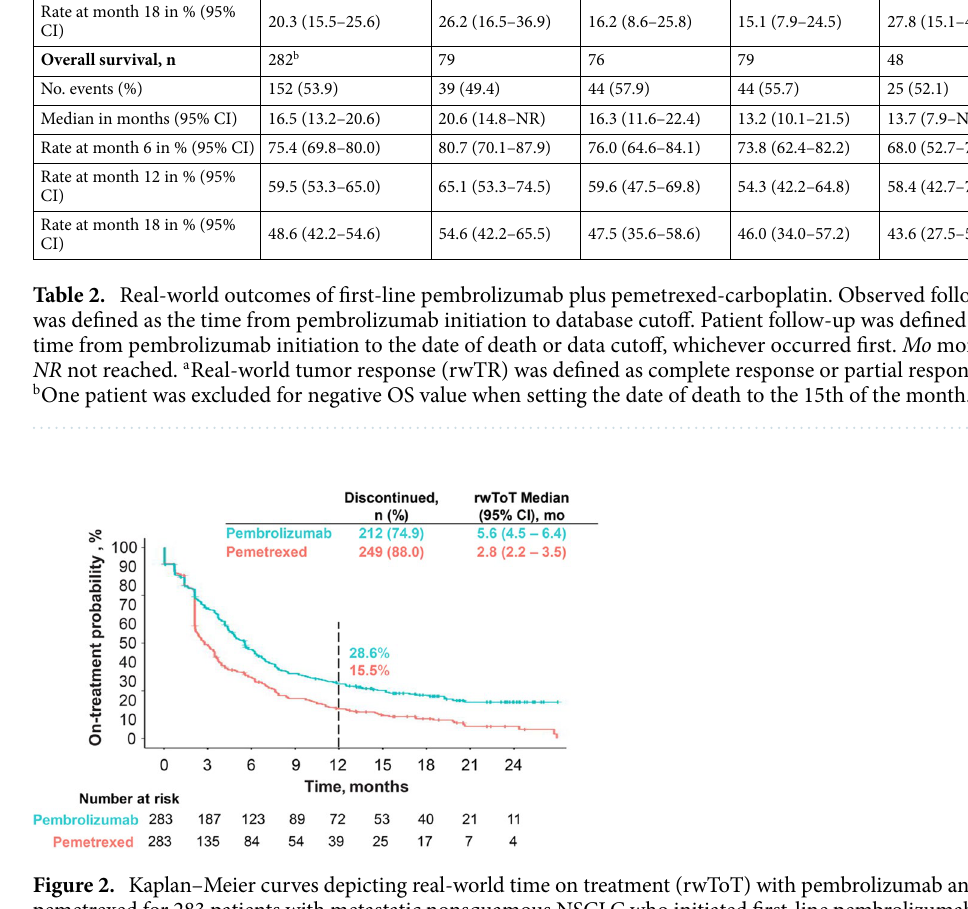
Figure 2. Kaplan–Meier curves depicting real-world time on treatment (rwToT) with pembrolizumab and pemetrexed for 283 patients with metastatic nonsquamous NSCLC who initiated first-line pembrolizumab plus